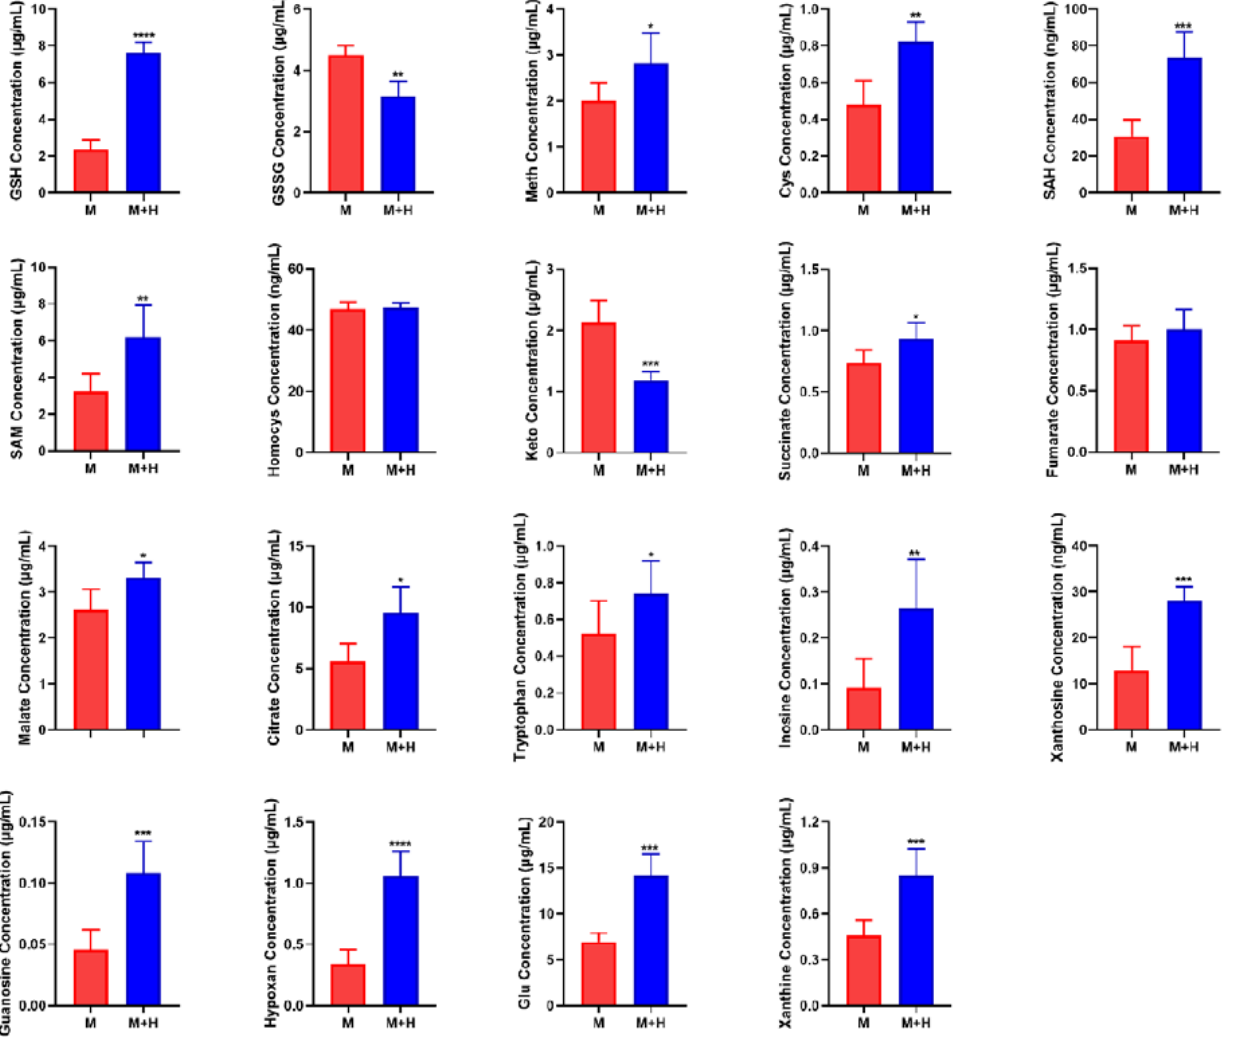
Figure 2. Quantitative analysis of biomarkers. The data are expressed as mean ± SD ( n = 6). * p < 0.05, ** p < 0.01, *** p < 0.001, **** p < 0.0001. Abbreviations are as follows: M represents MCF-7 cell single-culture group, M + H represents the co-culture group of MCF-7 and HUVEC cells. GSH, glutathione; GSSG, oxidized glutathione; Meth, methionine; SAM, S-adenosine methionine; SAH, S-adenosine homocysteine; Cys, cysteine; Hypoxan, hypoxanthine; Homocys, homocysteine; Glu, glutamate; Keto, α -ketoglutarate.